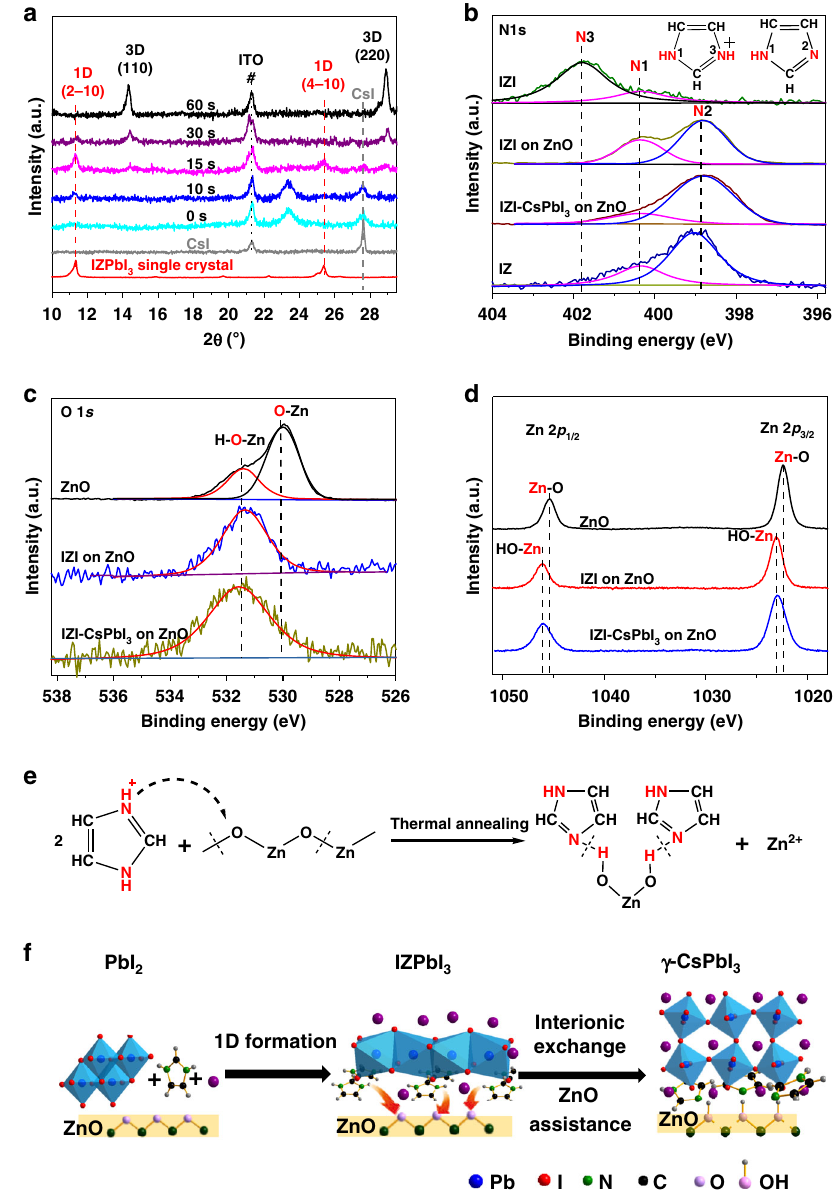
Fig. 2 Formation process of γ -CsPbI 3 perovskite on ZnO/PEIE substrate. a XRD patterns of IZI-CsPbI 3 fi lm on ZnO/PEIE substrate with different annealing time at 100 °C. XPS spectra of ( b ) N 1 s , ( c ) O 1 s , ( d ) Zn 2 p 1/2 and Zn 2 p 3/2 for IZI, IZI-CsPbI 3 fi lm on ZnO substrate and for IZI, IZ fi lm on ITO substrate, respectively. e Schematic diagram of deprotonation of IZ + with ZnO. f Mechanism of the γ -CsPbI 3 formation process at low temperature on ZnO